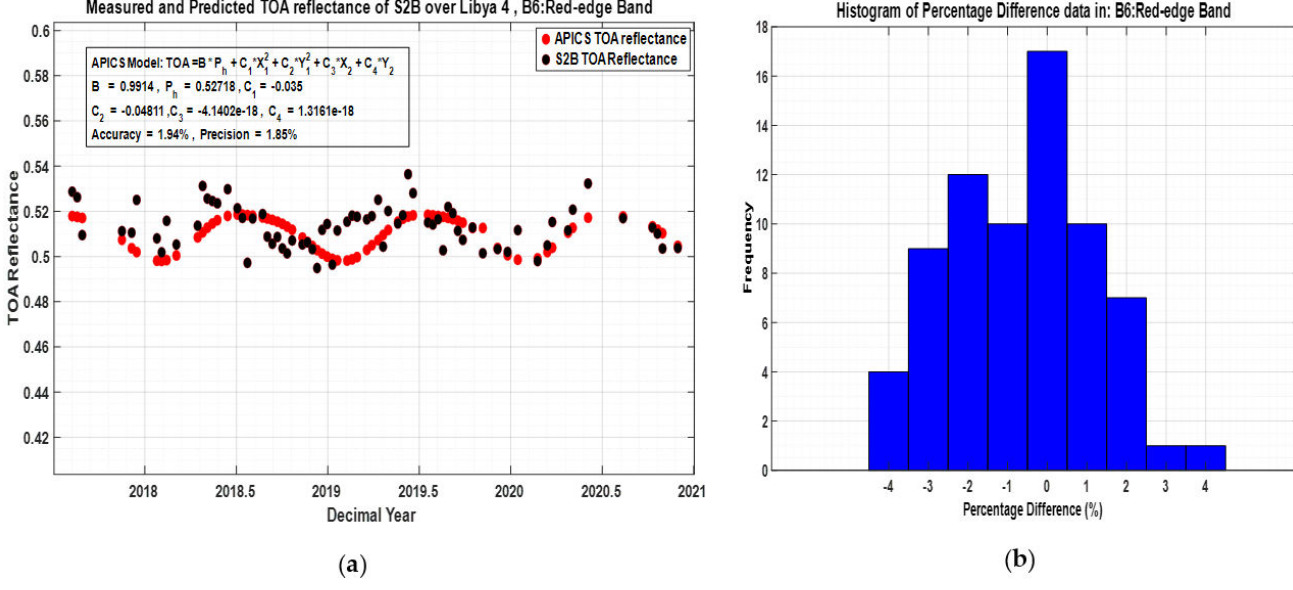
Figure 14. ( a ) S2B observation over Libya 4 (black circle) and model prediction (red circle) in Red-Edge band; ( b ) percentage difference analysis plots of the model in Red-Edge band of